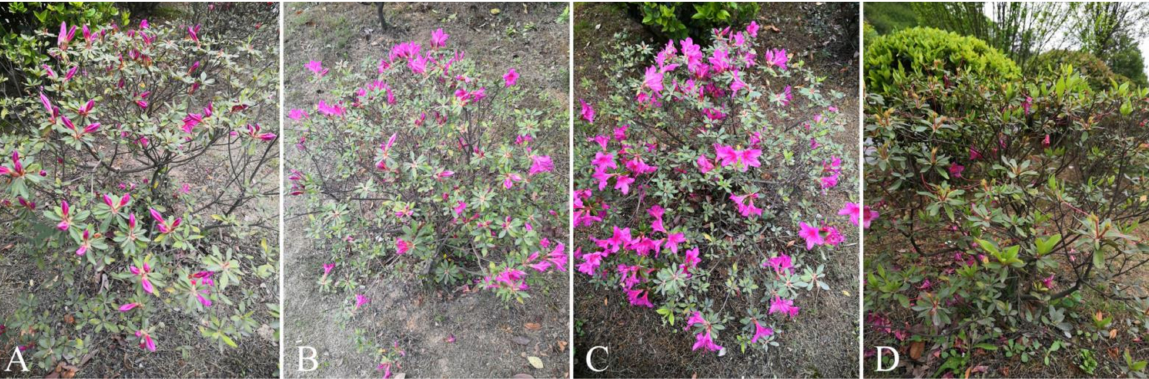
Figure 5. Opening dynamics of individual plants. ( A ): Squaring period; ( B ): initial flowering period; ( C ): blooming period; ( D ): end of flowering